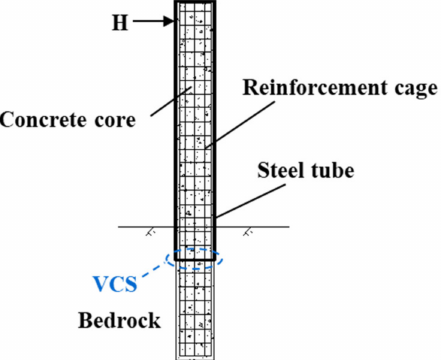
Figure 1. Illustration of the rock-socketed concrete-filled steel tube